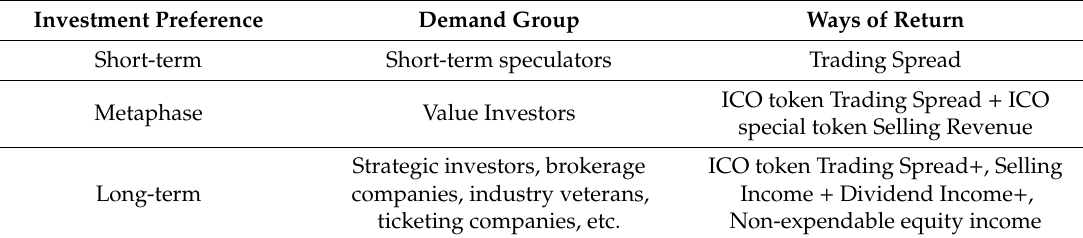
Table 1. Blockchain-encrypted currency investor